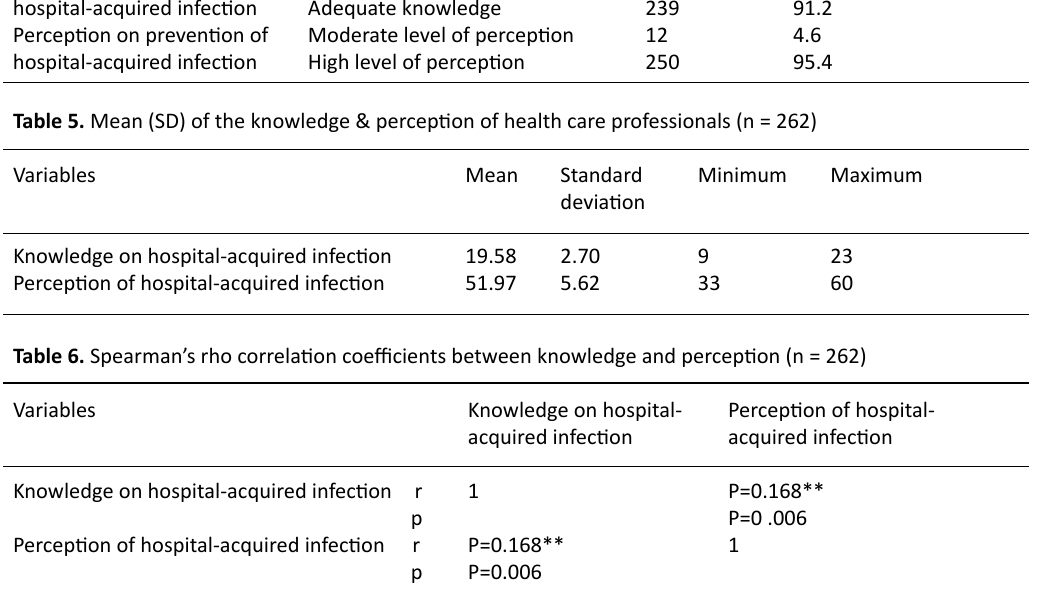
Table 4. Health professionals Knowledge & perception about the prevention of HAI (n = 262) Variables Levels Knowledge on prevention of